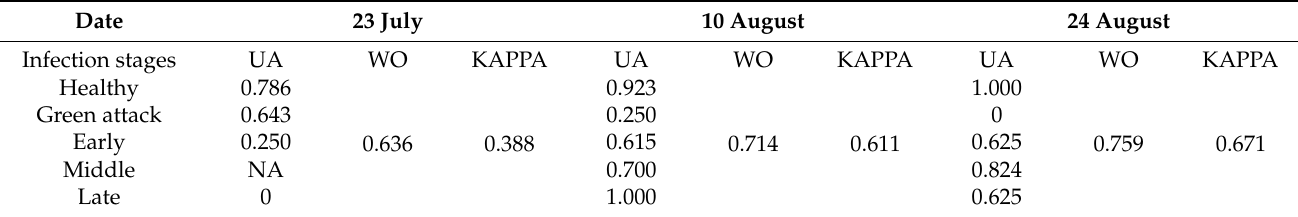
Table 4. Confusion matrix for several key